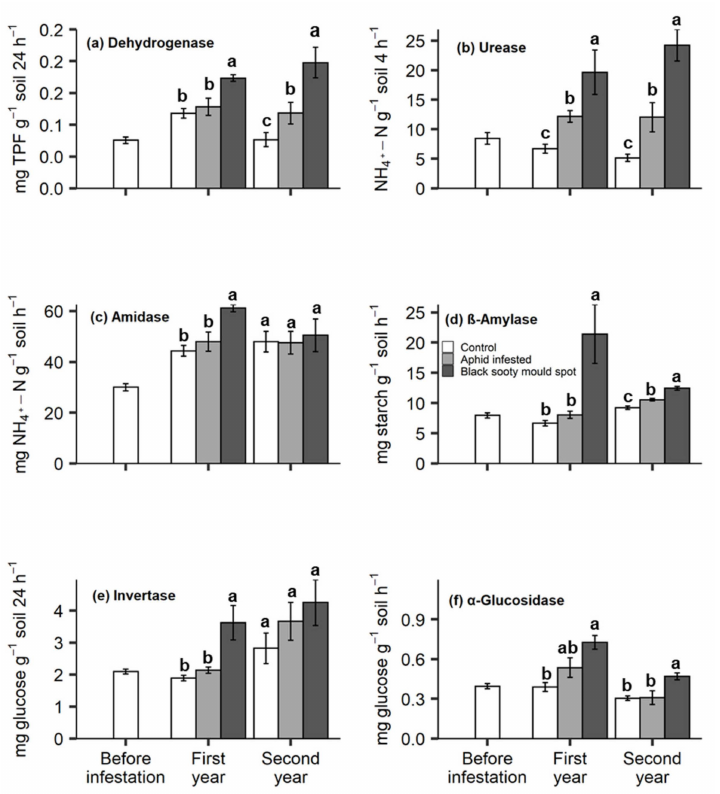
Figure 3. The activity of the soil enzymes: dehydrogenase ( a ), urease ( b ), amidase ( c ), β -amylase ( d ), invertase ( e ) and α -glucosidase ( f ) under the canopies of willow plants, prior to aphid inoculation (before infestation), and after aphid inoculation (control, aphid-infested, and black sooty mould spots) in the first and second year. The values are the means ± SE. Di ff erent letters indicate significant di ff erences between the treatments at each sampling time (Tukey’s HSD test, α = 0.05).